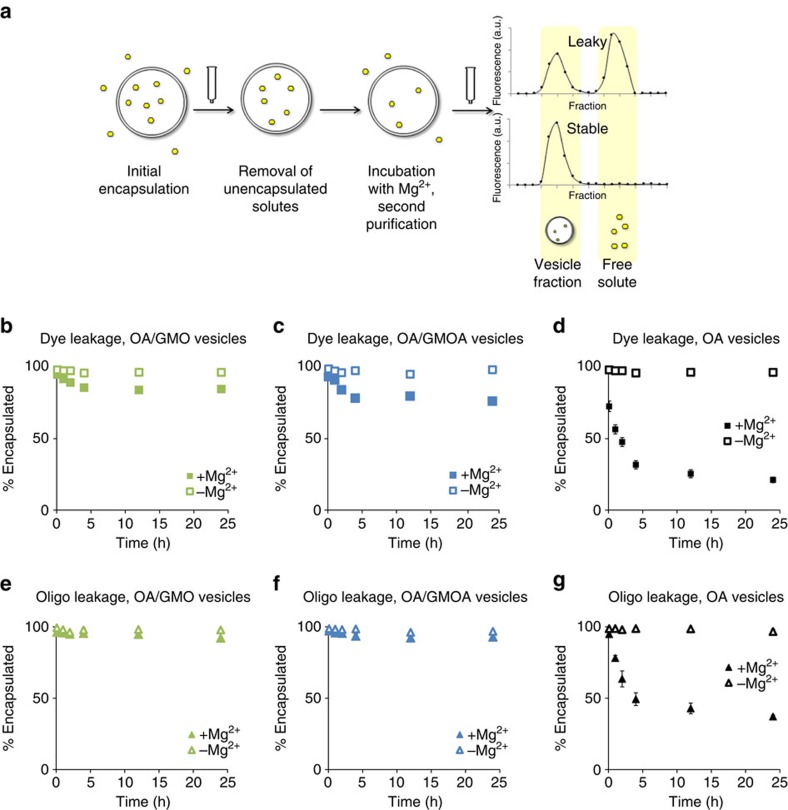
Vesicle leakage measurements.Magnesium-induced leakage of small molecules and oligonucleotides from vesicles of different membrane composition was assayed by encapsulation of the analyte of interest, removal of unencapsulated solutes, addition of magnesium (if applicable), followed by a second purification to quantitate leakage. General scheme of the vesicle stability experiment. (a) Columns between panels represent a size-exclusion chromatography step, in which vesicles are separated from unencapsulated solutes. Size-exclusion chromatograms shown here are intended to be schematic in nature only. Leakage of the encapsulated small molecule (calcein (b–d)) and oligonucleotide (e–g). Squares: small molecule leakage; triangles: oligonucleotide leakage. Green markers: OA/GMO vesicles; blue markers: OA/GMOA vesicles; black markers: OA vesicles. Error bars are s.e.m. (n=4); error bars that are not visible are sufficiently small they are obscured by markers. All reactions contained vesicles comprised of 50 mM total lipid (50 mM OA, or 42.5 mM OA, 7.5 mM (15 mol%) GMO or GMOA), and 0.2 M Na-glycinamide, pH 8.5 as buffer. Mg2+-containing samples were 15 mM in Mg2+. Calcein, when used, was present at 2.5 mM. Fluorescein-labelled oligonucleotide, when used, was present at 2 μM. Reactions were performed at uncontrolled room temperature (20±2 °C).